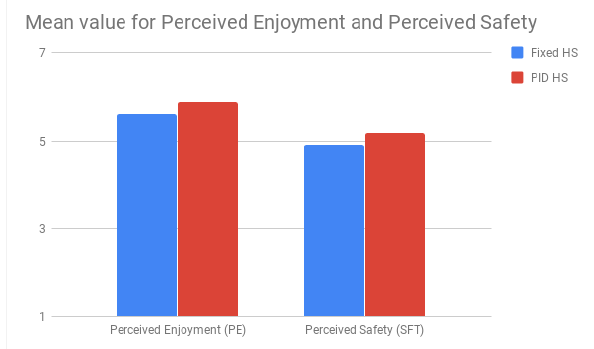
Figure 13: Mean values for Perceived Safety and Perceived Enjoy- ment.